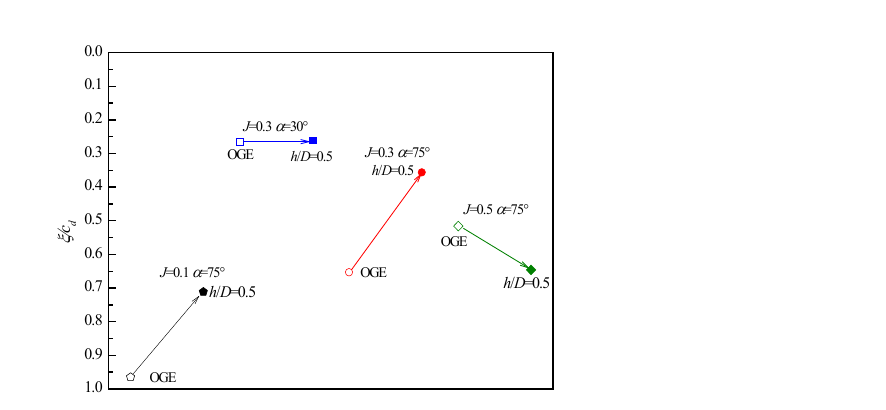
Figure 29. Comparison of stagnation point positions on the duct between in and out of ground ef- fect.